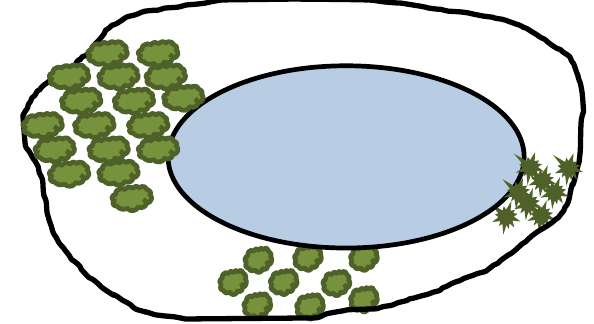
FIG. 1. School yard with a central lake and bunches of trees.